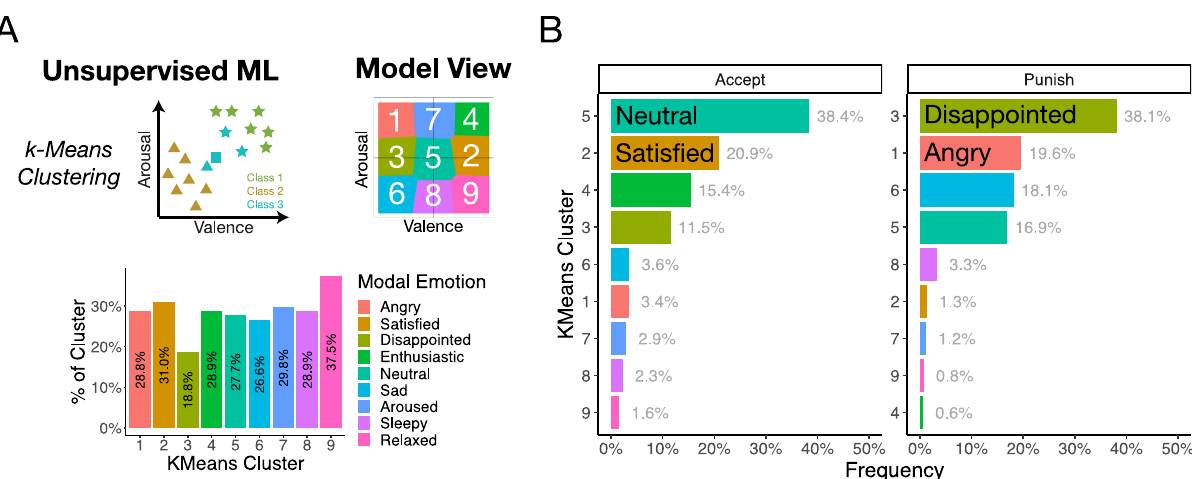
Fig. 5 k-means clustering approach. A k-means cluster schematic and interpretation. We speci fi ed the k-means algorithm to identify nine clusters which roughly forms a three-by-three grid varying in low, medium, and high valence and arousal. Each cluster is numbered and the frequency of the modal emotion for each cluster is shown to illustrate each space of the emotion grid. B Classi fi cations by decisions to accept and punish. The k-means cluster model was applied to the unlabeled emotion ratings from the Ultimatum Game. Each data point is categorized by a single cluster and the frequency of each cluster is shown for accept and punish decisions.